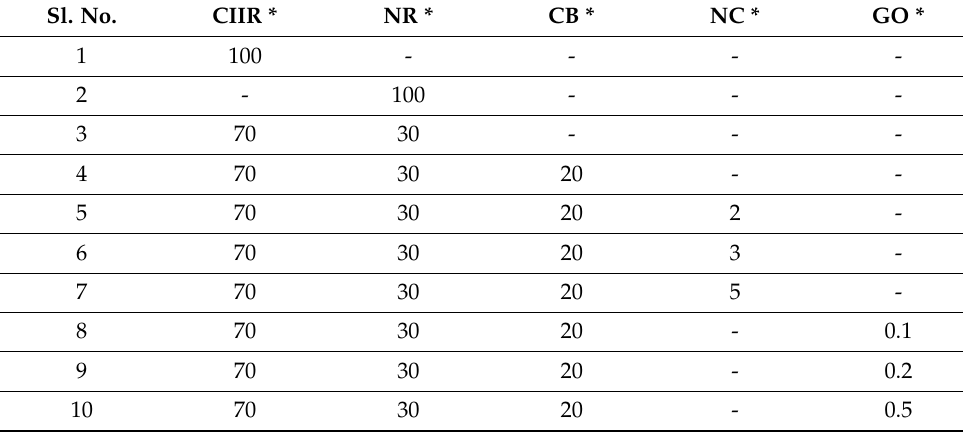
Table 2. The formulations used for the preparation of polymer nanocomposites. * Phr—parts per hundred rubbers by